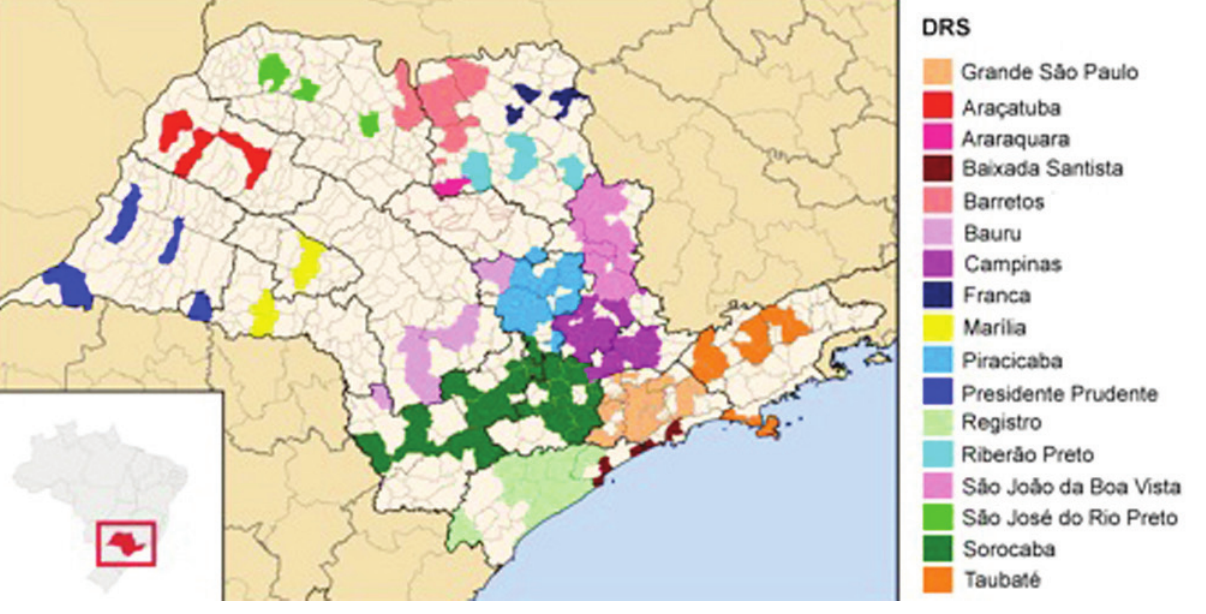
Figure 3. Geographical location of 143 municipalites, according to Regional Department of Health (DRS), with anti- P. brasiliensis antibody detection from January 1999 to May